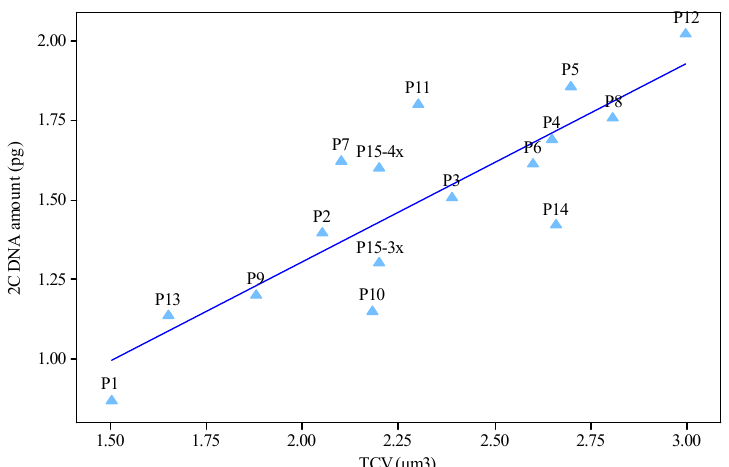
Figure 7. Linear relationship between 2C DNA amount (pg) and chromosome volume (b = 0.72 **) ** p < 0.01) of 15 Hypericum perforatum populations.